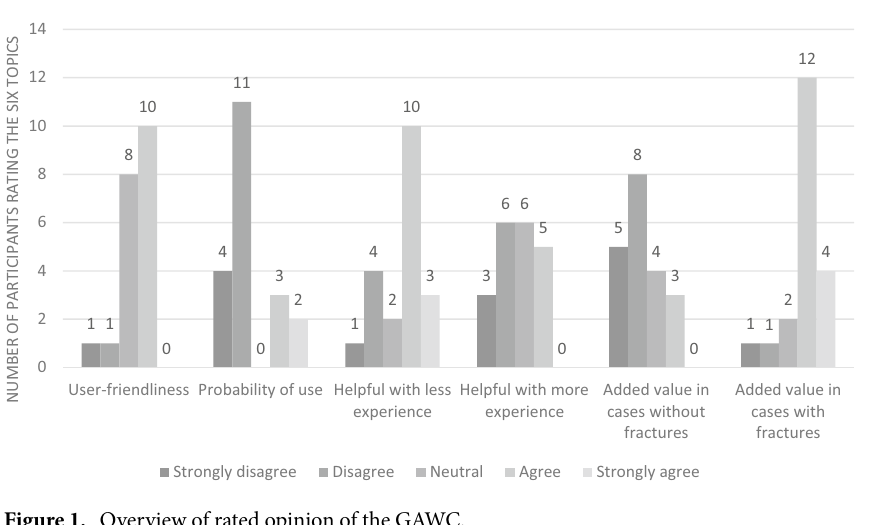
Figure 1. Overview of rated opinion of the